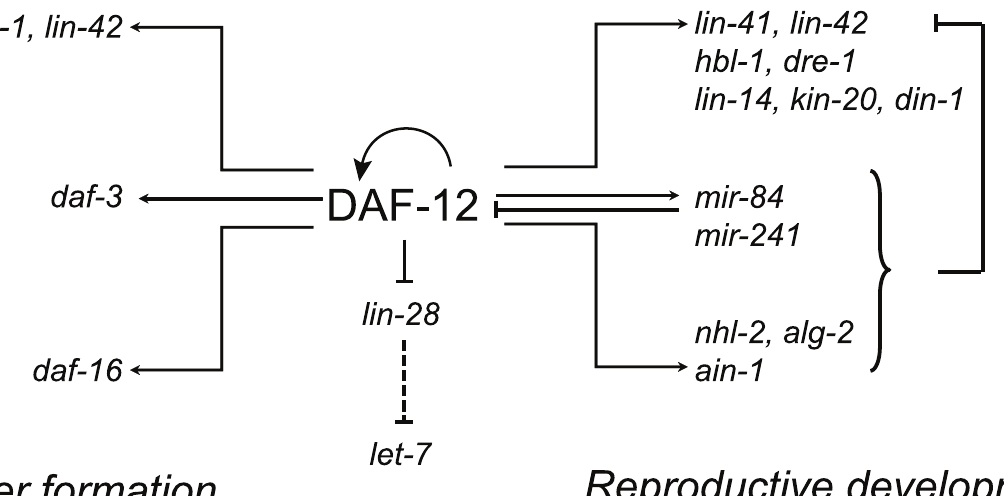
Figure 9. Multi-level control of genes involved in developmental decisions by DAF-12. The nuclear receptor directly regulates the heterochronic circuit, miRNA biogenesis and miRISC expression at the transcriptional level. Other regulators of miRNA activity, such as lin-28 are repressed by DAF-12. Together the miRNA and miRISC regulate the levels and translation of many heterochronic genes. DAF-12 also promotes dauer entry by regulating dauer loci. Finally, DAF-12 regulates its own expression and is also a target for